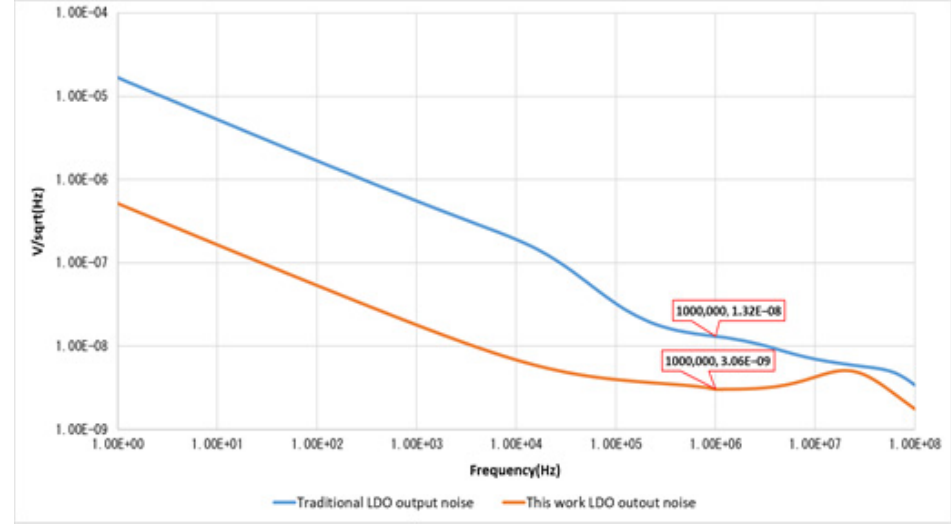
Figure 5. Comparison of output noise simulation results of the conventional LDO and the proposed LDO.